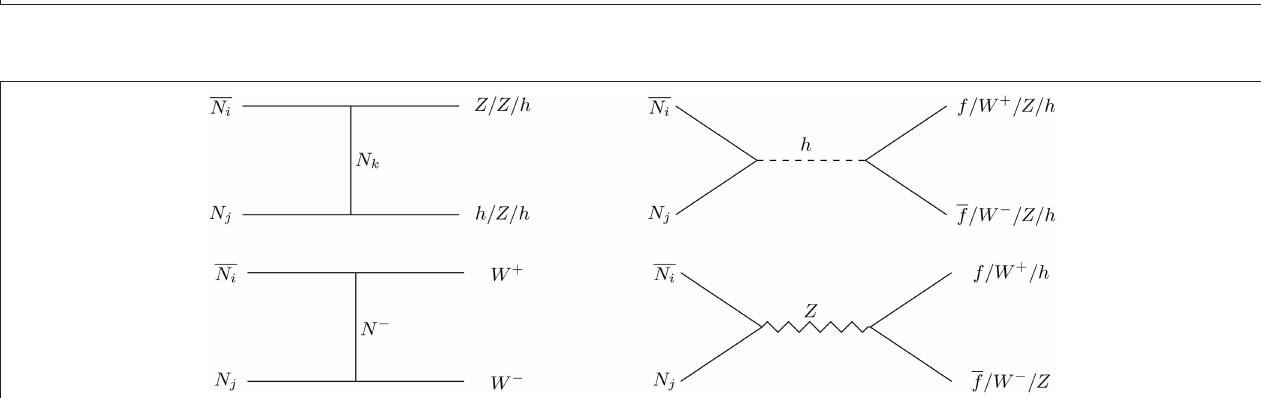
FIGURE 16 | In the left panel, ˆ T is shown as a function of m N sin θ 0.15 (Black color), and sin θ = sin θ 0.1 (Red color), and sin θ =